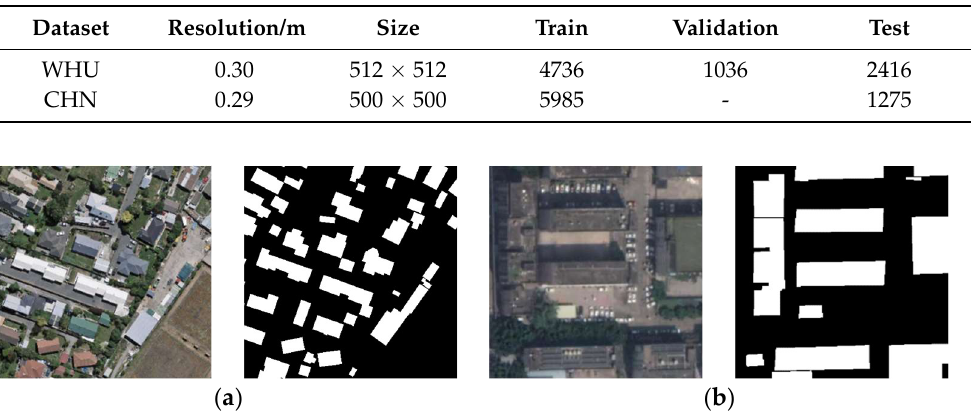
Figure 7. Examples of the images and corresponding labels for the two employed datasets. ( a , b ) represent the WHU dataset and CHN dataset, respectively. The white pixels stand for buildings.